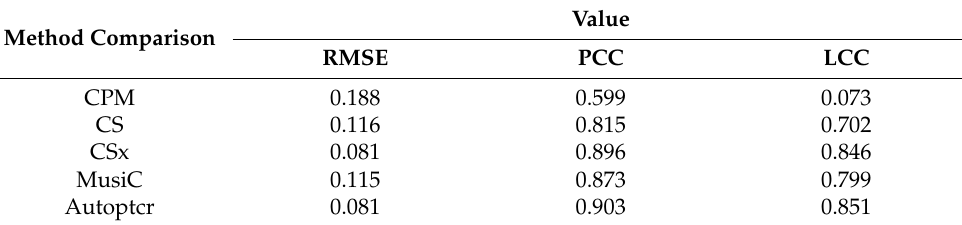
Table 2. Average performance of CPM, CS, CSx, MusiC, and Autoptcr on four datasets. Method Comparison